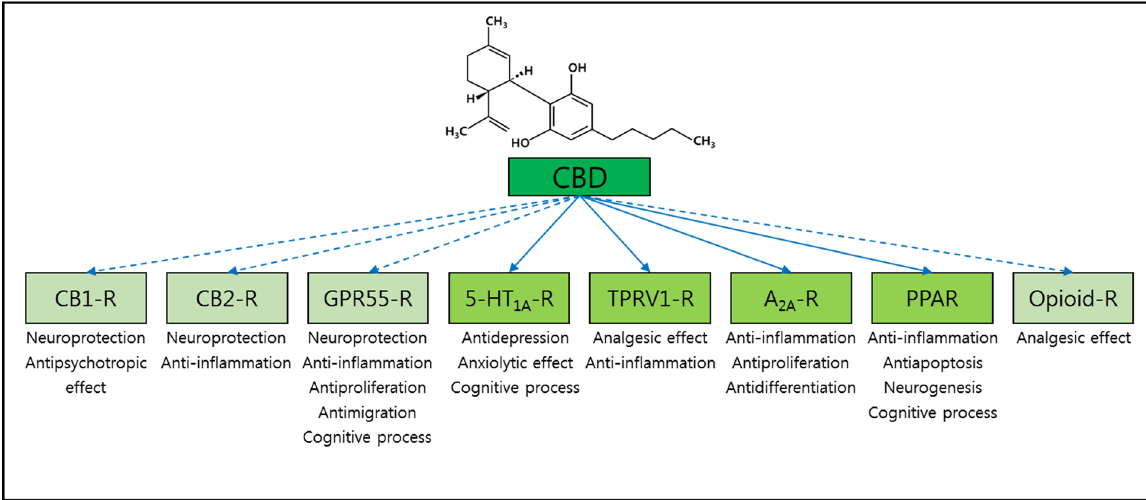
Figure 3. Potential biological targets of CBD in AD treatment. Based on the property of each potential receptor target of CBD and well-known mechanism studies of CBD-mediated therapeutic functions, several potential biological targets of CBD involved in AD treatment have been proposed, including CB1, CB2, GPR55, 5-HT 1A , TPRV1, A 2A , PPARs, and opioid receptors. Black arrows indicate receptors activated by CBD, whereas dotted arrows indicate receptors inhibited by CBD. The therapeutic roles of CBD mediated by each receptor are listed underneath to provide insights for CBD application in AD treatment.